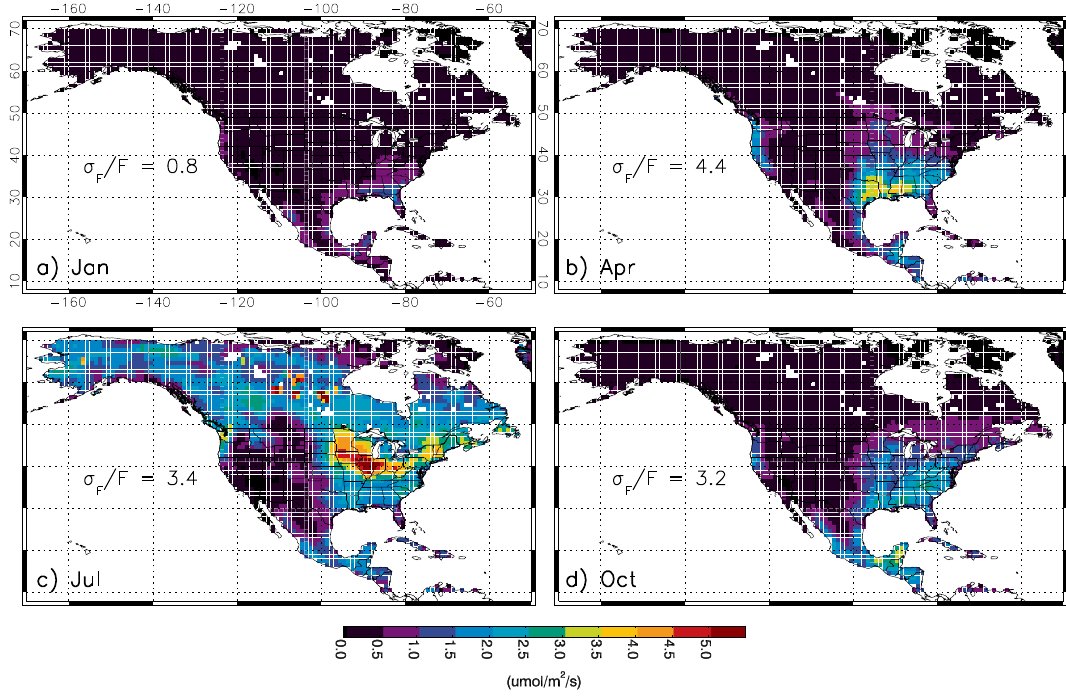
Figure 3. A priori weekly flux uncertainty for (a) January, (b) April, (c) July, and (d) October. Average fractional flux uncertainties over the domain are given in each panel (where F is flux). 1µmolm − 2 s − 1 = 1 . 037gCm − 2 d − 1 = 4 . 4 × 10 − 8 kg CO 2 m − 2 s − 1